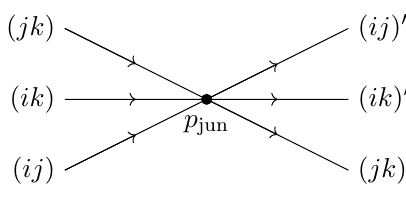
Figure 4 . Junction of WKB